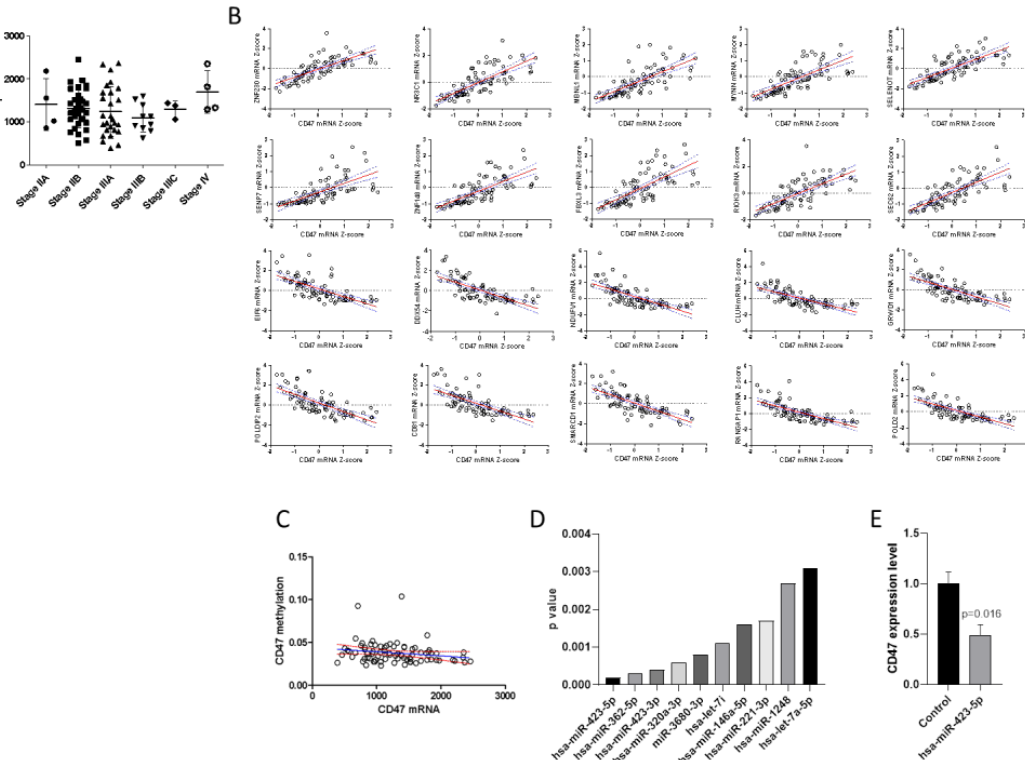
Figure 1. ( A ) Expression of cluster of differentiation 47 (CD47) in uveal melanoma (UM) samples at different TNM stages; ( B ) Top 10 positively correlated and negatively correlated genes to CD47 expression in UM samples; ( C ) Correlation between CD47 expression and methylation levels in UM samples ( D ) Top 10 miRNAs inversely correlated to CD47 expression levels as determined in the TCGA (The Cancer Genome Atlas) dataset; ( E ) Modulation of CD47 expression upon transfection of 92.1 cells with hsa-miR-423-5p mimic.